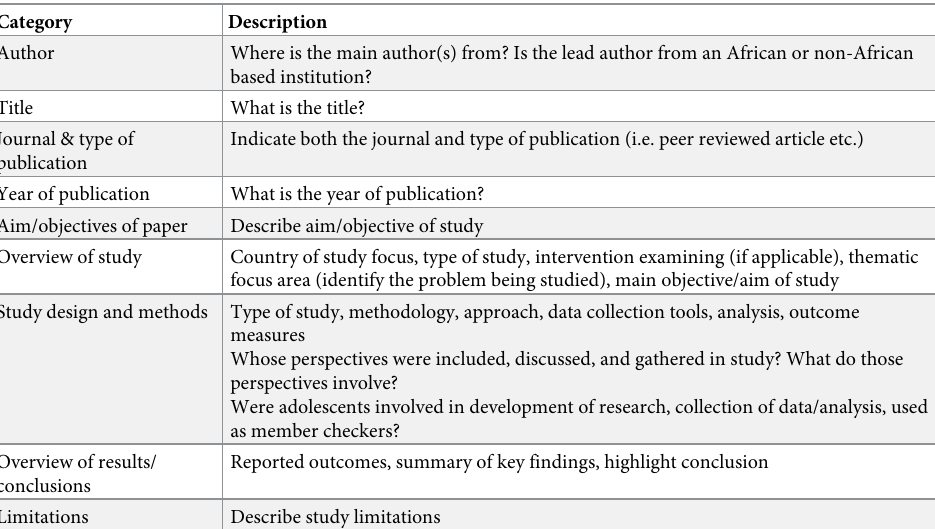
Table 1. Data extraction